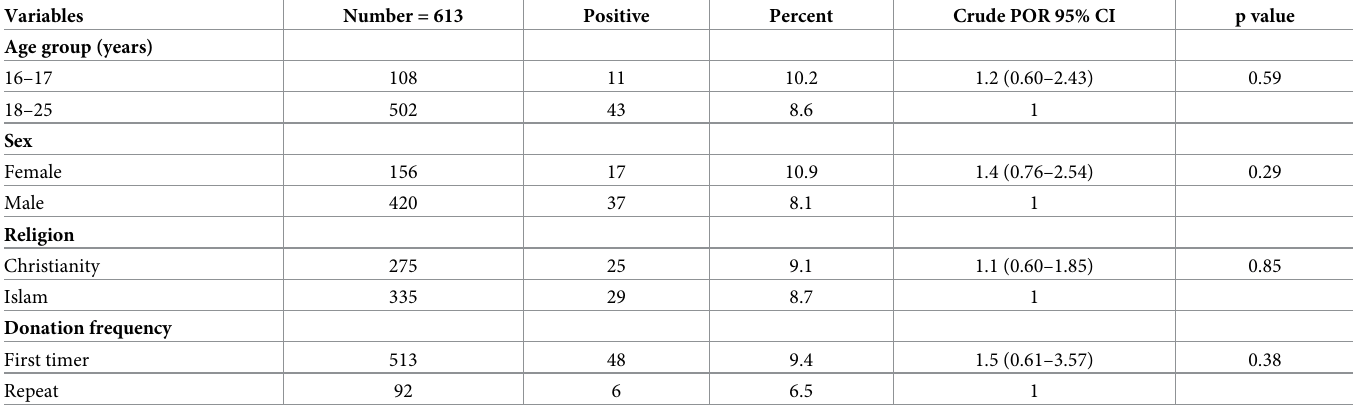
Table 3. Bivariate analyses of voluntary school-going adolescents’ blood donors at KSBTC, January 2020-June 2021 (n =